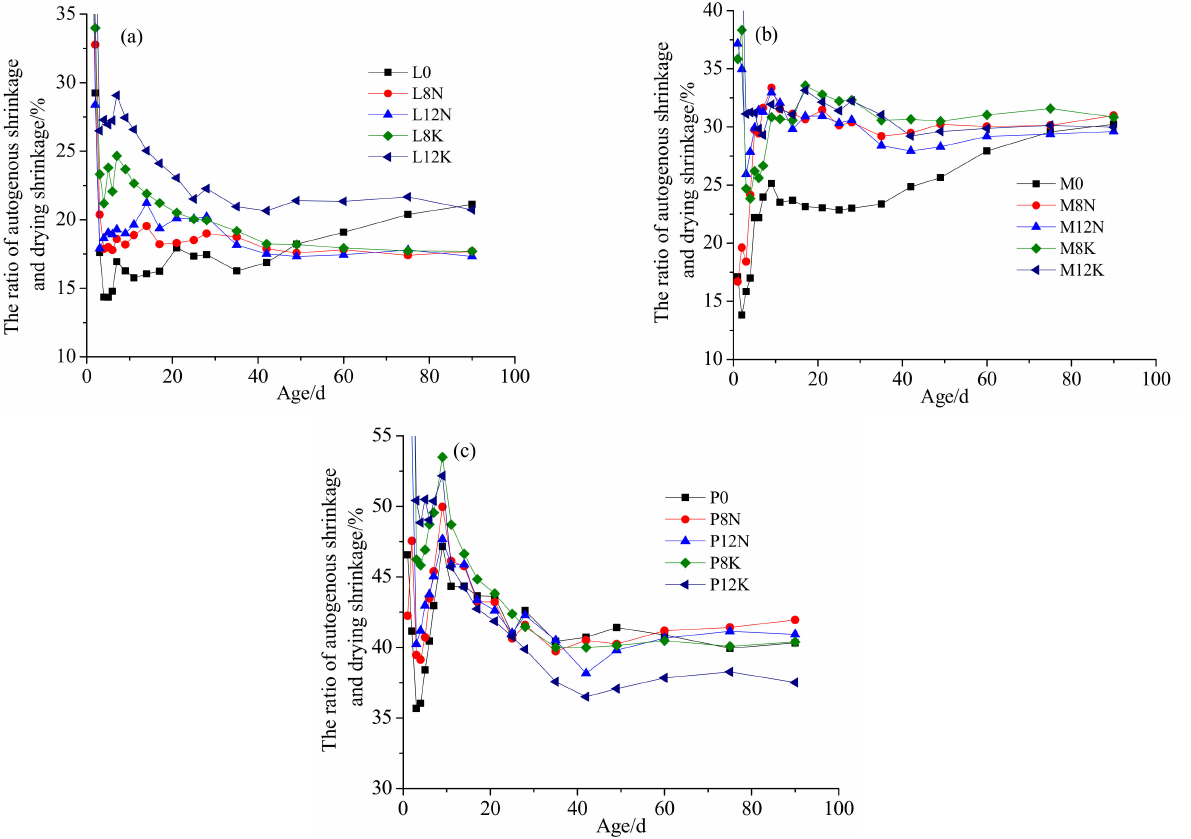
Figure 5. The ratio of autogenous shrinkage and drying shrinkage of mortars with different alkali sulfates contents. ( a ) LHPC; ( b ) MHPC; ( c ) OPC